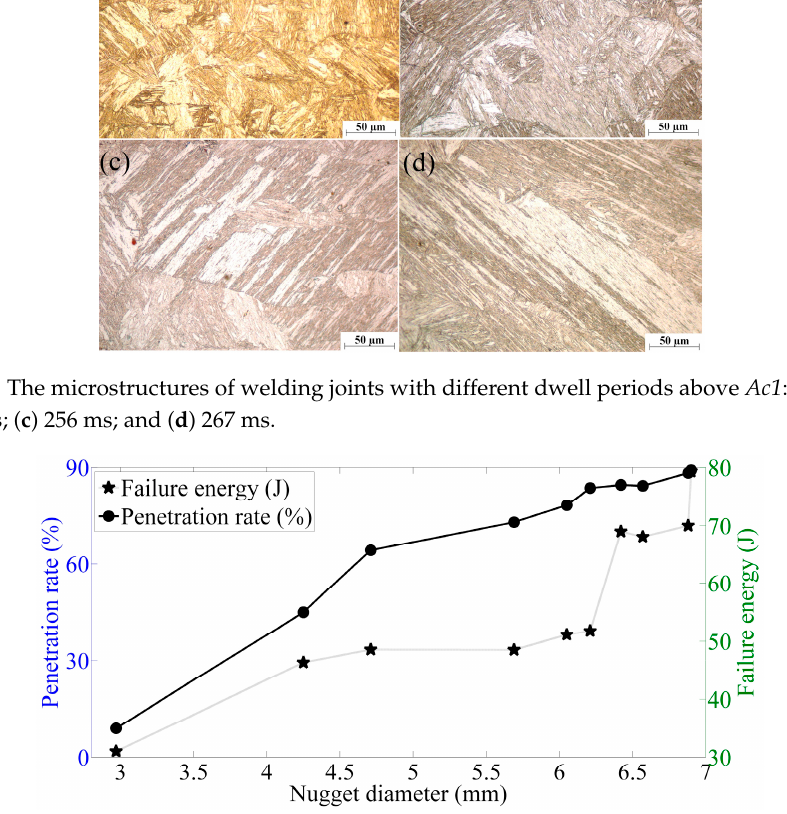
Figure 15. The microstructures of welding joints with different dwell periods above Ac1 : ( a ) 156 ms; ( b ) 234 ms; ( c ) 256 ms; and ( d ) 267 ms.